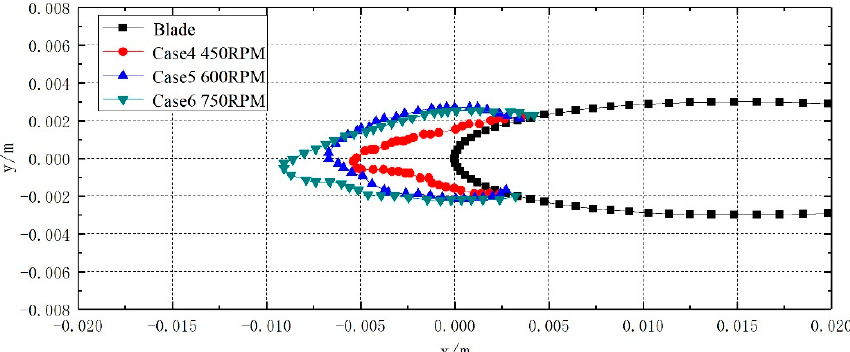
Figure 8. Ice shapes under different rotation speeds: ( a ) case 4, rotation speed was 450 Revolutions Per Minute (RPM); ( b ) case 5, rotation speed was 600 RPM; ( c ) case 6, rotation speed was 750 RPM.